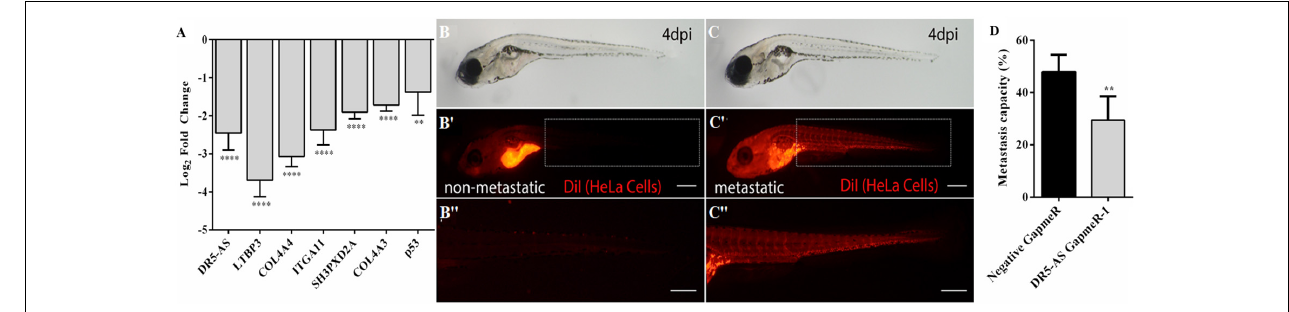
FIGURE 8 | Analysis of metastasis rate in zebrafish xenograft assay. (A) qPCR analysis of metastasis-related genes in HeLa cells transfected with DR5-AS GapmeR-1. DR5-AS was knocked down in HeLa cells by transfecting the cells with DR5-AS GapmeR-1 for 72 h. qPCR was carried out with total RNAs isolated from cells transfected with negative GapmeR and DR5-AS GapmeR-1. To examine the metastasis rate in the zebrafish xenograft assay (B–C”) , control cells and DR5-AS GapmeR treated cells were injected to the yolk of 2 dpf zebrafish. (B–B”) Xenografts with non-metastatic tumors display local tumors at the injection site (B’) . No tumor cells are detectable in the body (B”) . In metastatic xenografts (C–C”) , tumor cells are detected in the injection site (C’) and rest of the body ( C” a closeup view of cells in the tail region). (D) Percentage of metastatic larvae is 47.9% in control group whereas it is 29.5% in DR5-AS GapmeR group. The graph is plotted based on average of 3 replicates of each cell type ( n = 18–20 per set), and 2 independent experiments. Dashed boxes in ( B’ , C’) indicate the regions imaged in (B”,C”) , respectively. Scale bars represent 500 µ m. Images were recorded with Olympus SZX16 stereomicroscope. ** p ≤ 0.01, **** p ≤